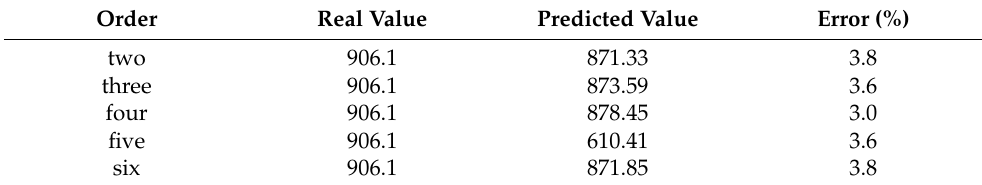
Table 6. The error of different multi-order polynomial for EGT4. Table 3. The error of different multi-order polynomial for EGT 1